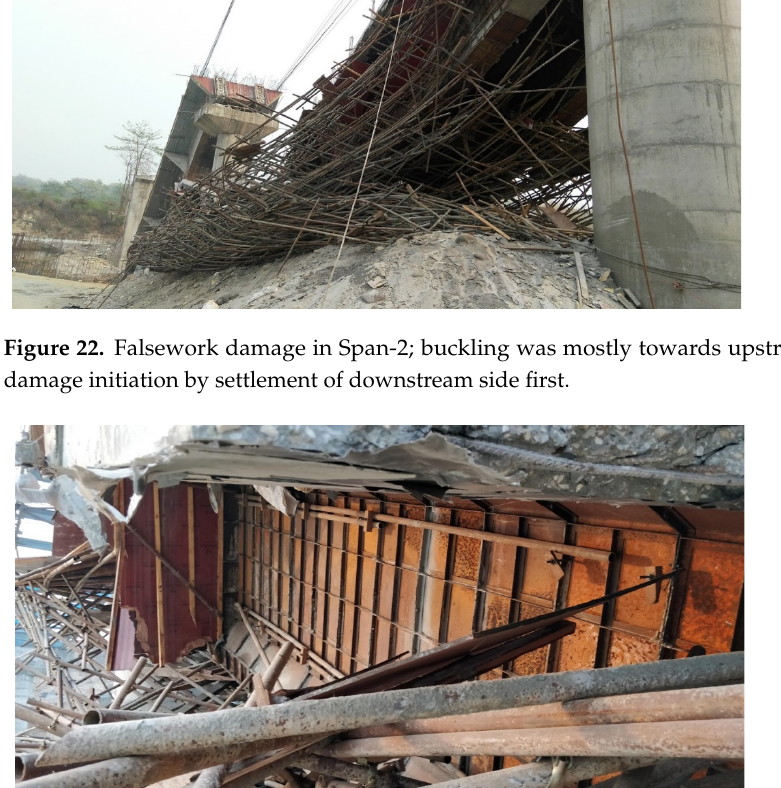
Figure 23. Intact formwork on other part of Span-2 (except the beam fracture location), indicating failure mechanism consists only one failure location.